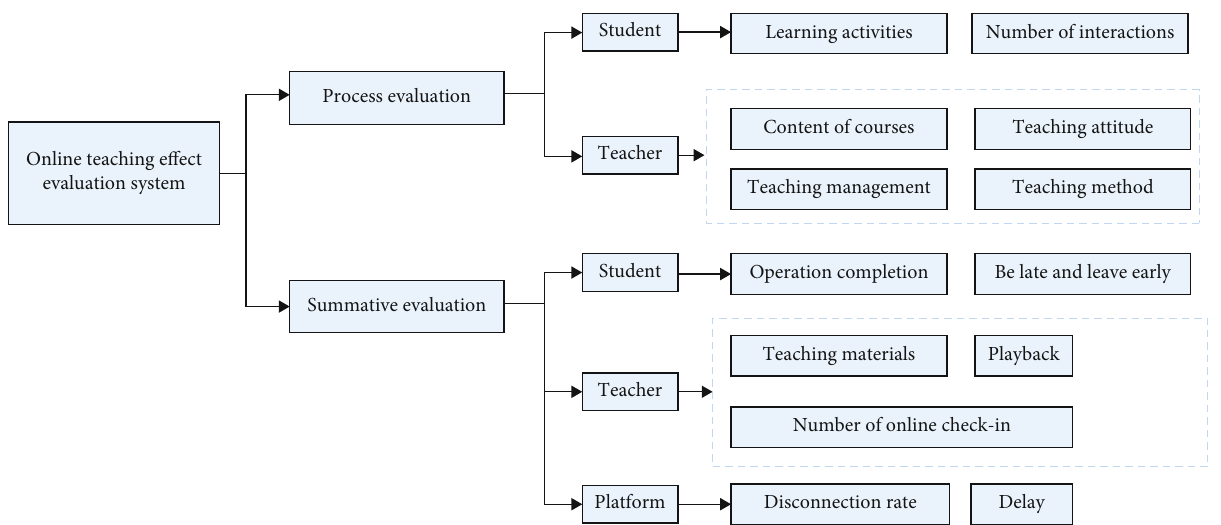
Figure 5: Flow chart of the whole